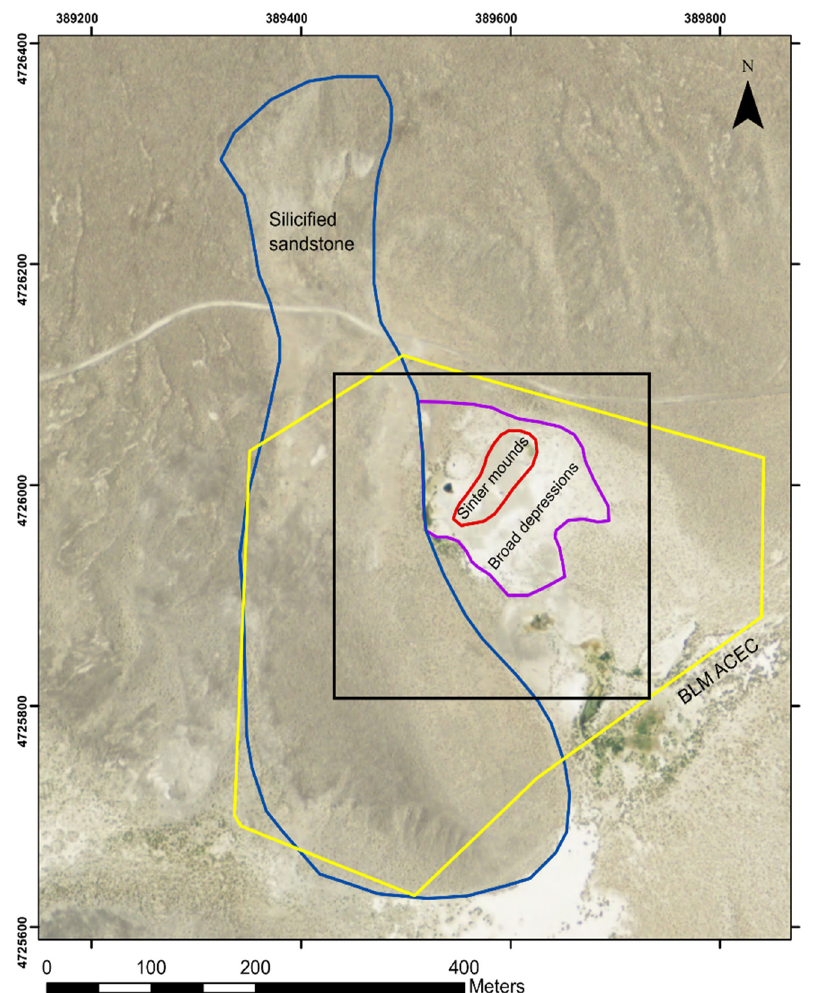
Figure 4. Three morphologies of sinter were identified at Mickey Springs: (1) sinter aprons surrounding narrow depressions (outlined in purple); (2) sinter ‐ rimmed broad depressions blanketed with loose fine ‐ grained sediment (outlined in red); and (3) silica ‐ cemented conglomeratic to fine ‐ grained sandstone (outlined in solid blue). Black box indicates the outline for Figure 5. Yellow line indicates the extent of Area of Critical Environmental Concern (ACEC) managed by BLM.